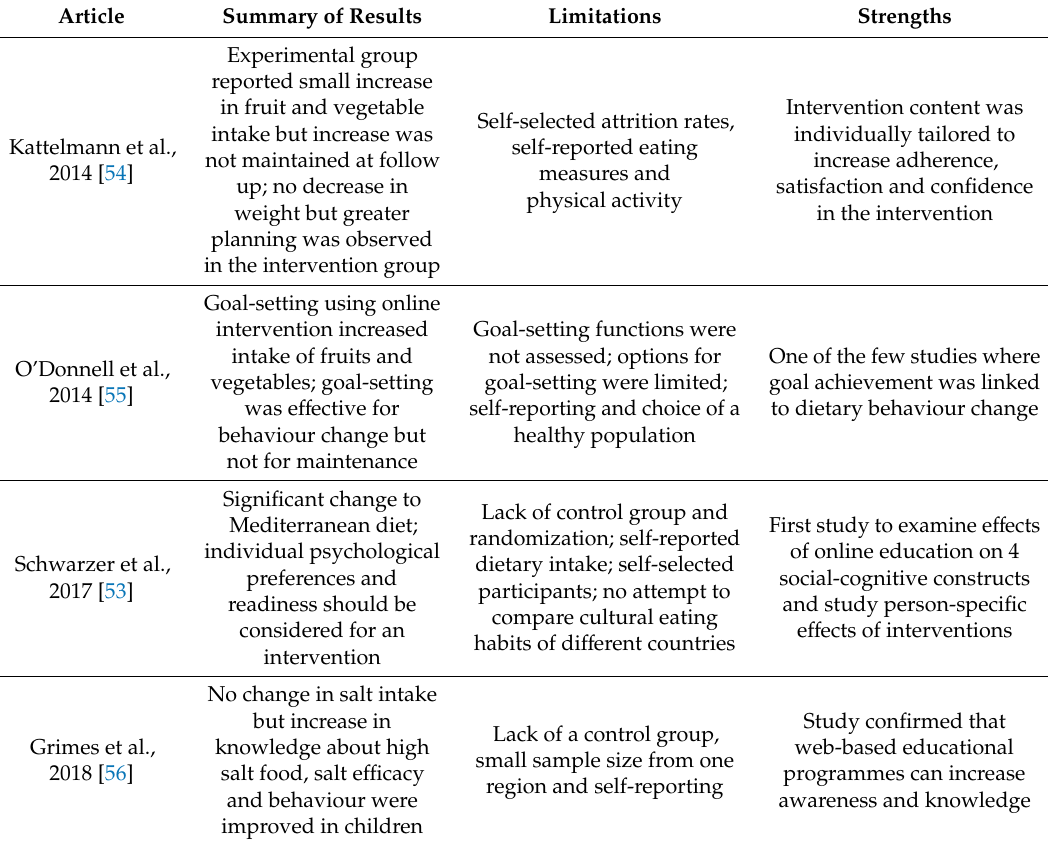
Table 3. Summary of results in studies using online education as a digital intervention for dietary behavior